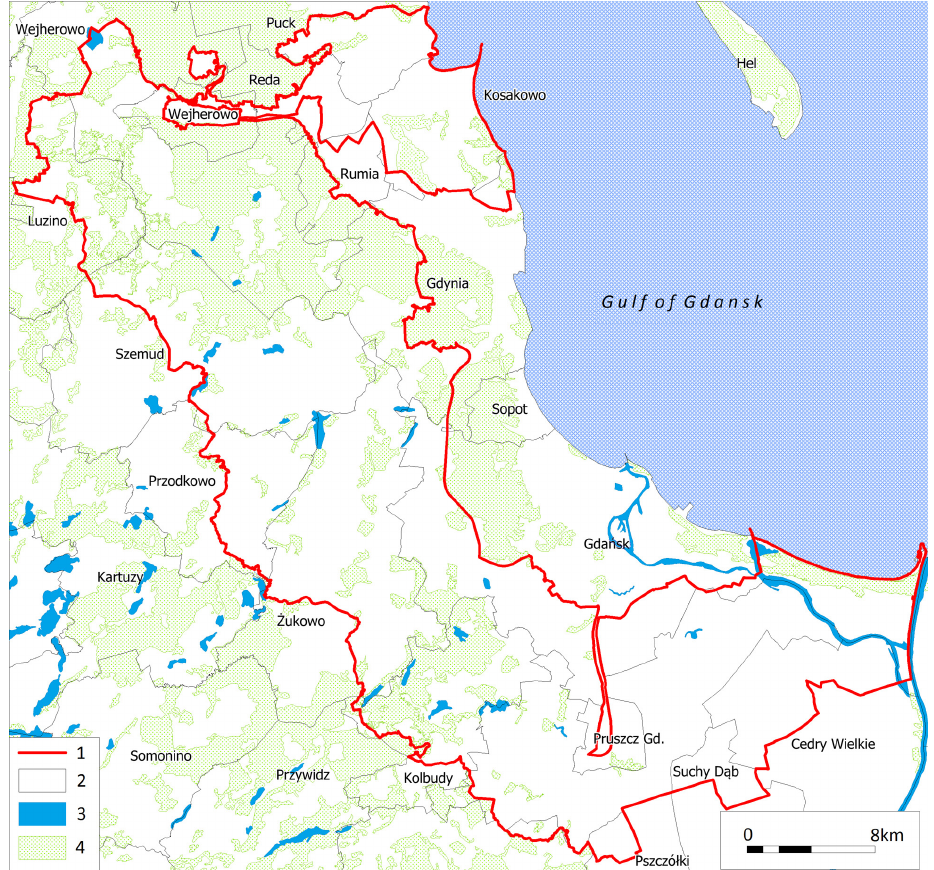
Fig. 1. location of the research area on the background of the administration division of the Pomeranian